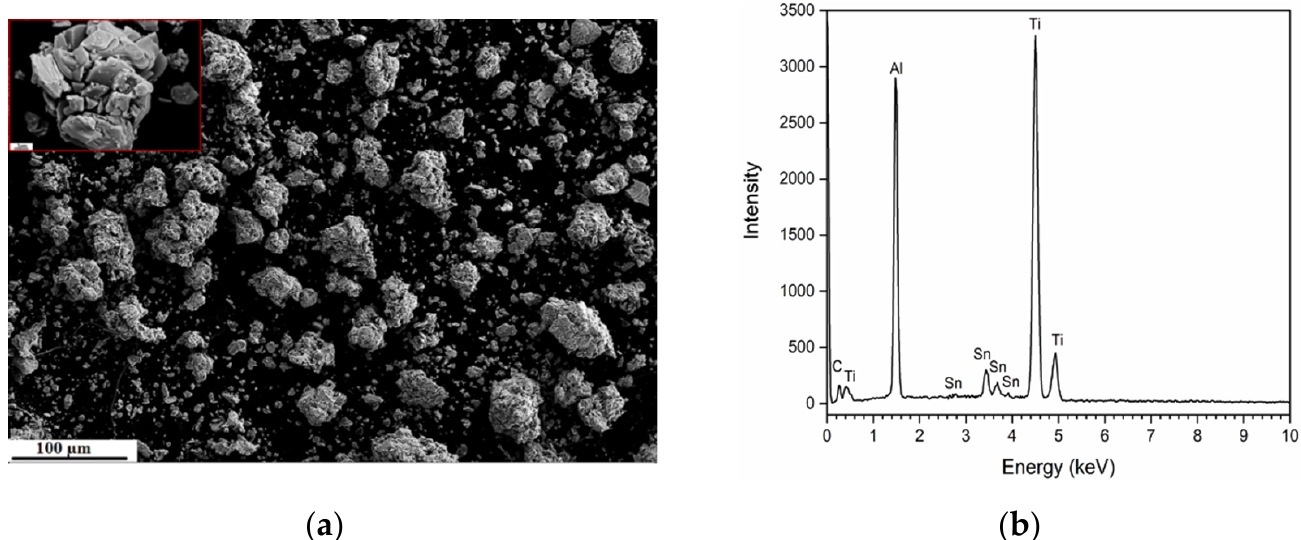
7 of 16 Table 4. BET analysis and Helium pycnometry for Ti 3 AlC 2 powder. Parameter 4.527 Table 5. O:N:H content. Parameter